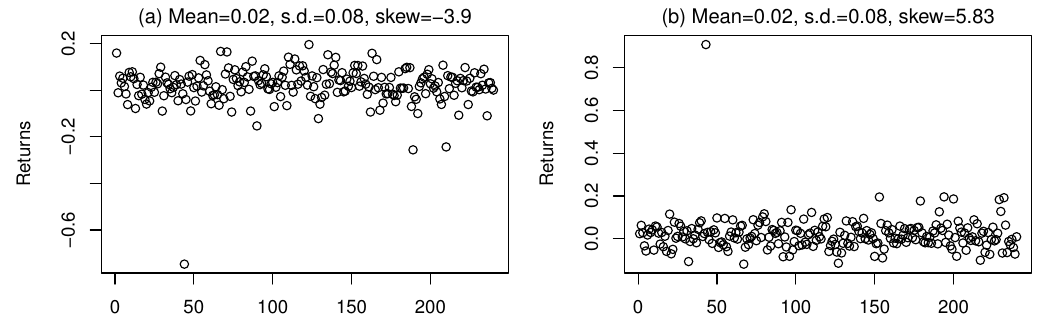
Figure 2. Two very different series with the same mean and standard deviation. ( a ) Negatively skewed series; ( b ) Positively skewed